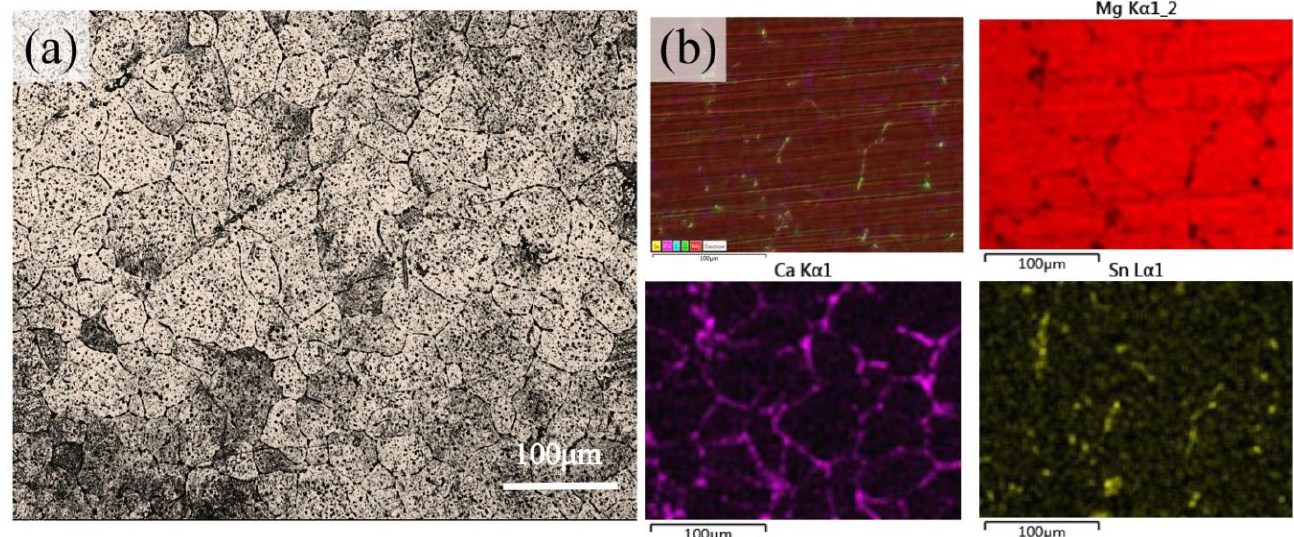
Figure 1. ( a ) Optical micrograph and ( b ) EDS elemental maps of the homogenized Mg − 2Sn − 1Ca alloy.